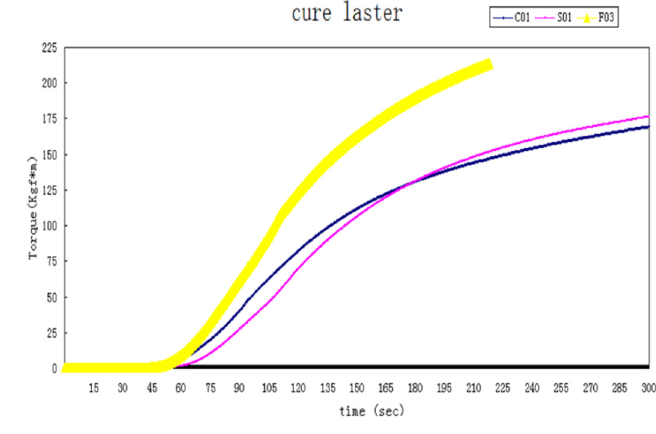
Figure 11. The effect of filler type and shape on curing.